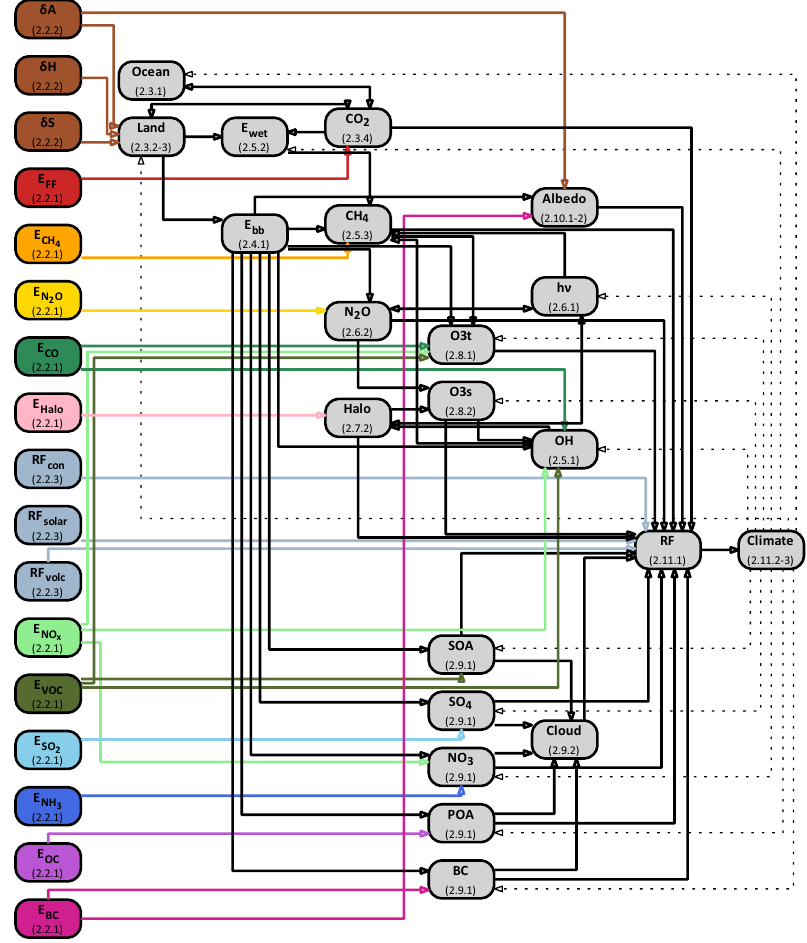
Figure 1. Simplified causal chain of OSCAR v2.2. Each node of the graph corresponds to a module described in the section whose number is shown below the node’s name. Colored lines show the forcings of the model, black lines show the natural cause-effect chain, and dashed lines show the climate feedbacks. “Halo” groups all the halogenated compounds, “Ocean” is the ocean carbon cycle, “Land” is the land carbon cycle, “Albedo” groups the surface albedo effects, “ hν ” is the stratospheric chemistry, “OH” is the tropospheric chemistry, “Cloud” is the indirect aerosol effect, and “Climate” groups the surface temperatures and